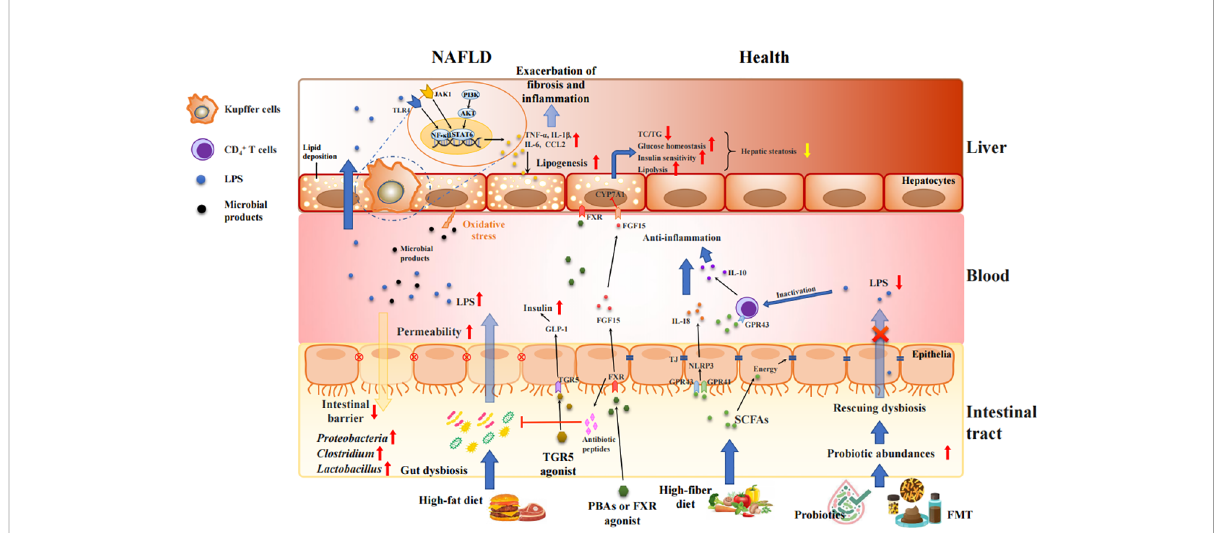
FIGURE 2 Intestinal barrier disrupted by gut dysbiosis facilitates bacterial endotoxins to liver and exacerbates in fl ammatory process and fat accumulation in the pathogenesis of NAFLD. Unhealth lifestyle (e.g., high-fat, low- fi ber diet) alters the microbiota colonization in gut, increases gut permeability, and produces various proin fl ammatory molecules, such as LPS, TMAO, SBAs, and bacterial 16sDNA. These proin fl ammatory molecules worsen the liver in fl ammation and fi brosis and potentially accelerate NAFLD progression. Treatment with FXR/TGR5 agonist, probiotics and FMT strengthens intestinal tight junction, and mediates the glucose and lipid metabolism via activation of FXR and TGR5 signaling as well as inhibition of TLR4//NF- k B and JAK1/STAT6